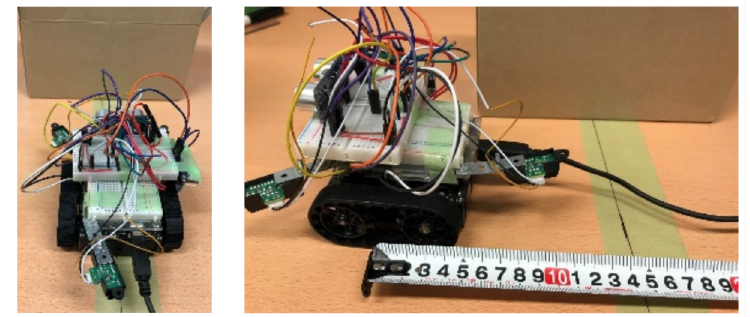
Figure 13. Robot detecting the obstacle ( left ); robot during obstacle avoidance ( right